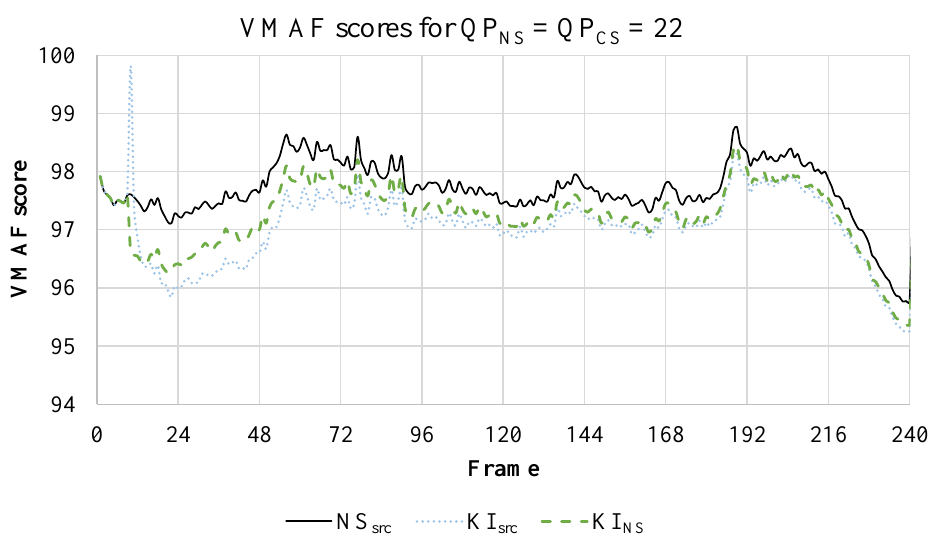
Figure 4. Video Multimethod Assessment Fusion (VMAF) scores of the ParkScene -sequence, encoded with QP NS = QP CS = 22. On average, KI NS has a smaller quality decrease than KI src .